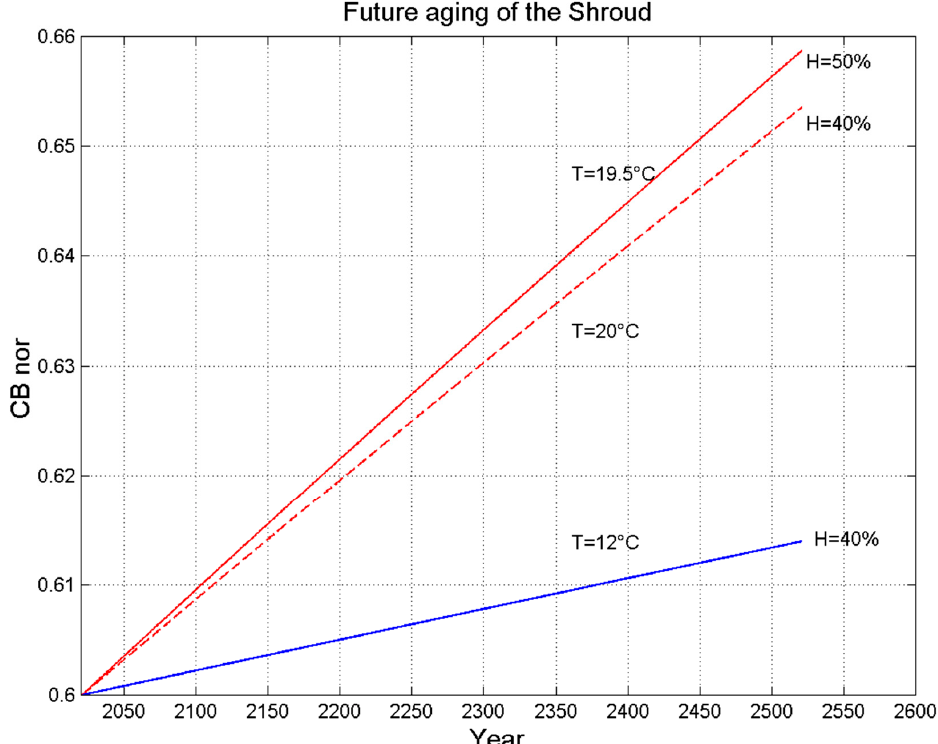
Figure 10. CB nor predicted from 2022 to 2521 for the aging of the Shroud kept in the actual reliquary at different conditions, with a controlled atmosphere of 99.5% Argon and 0.5% Oxygen: red continuous line, H = 50% and T = 19.5 ◦ C (actual conditions); red dashed line, H = 40% and T = 19.5 ◦ C—conditions proposed in [40]; blue line, H = 40% and T = 12 ◦ C—conditions suggested in this work.